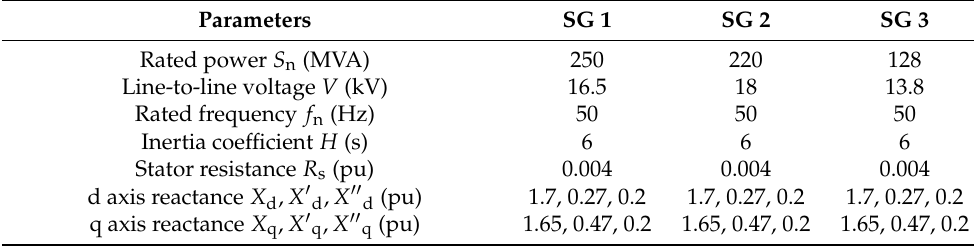
Table A1. The parameters of the synchronous generators.